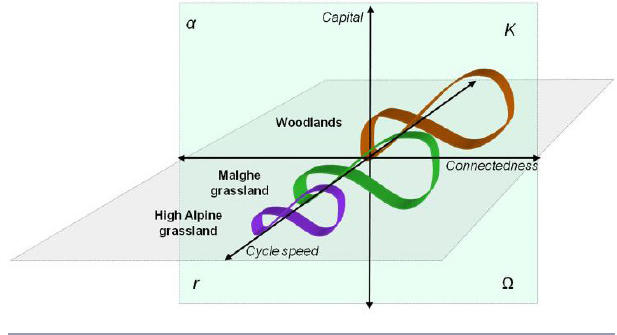
Fig. 3 . Three adaptive cycles at the Malga system (based on Gunderson and Holling